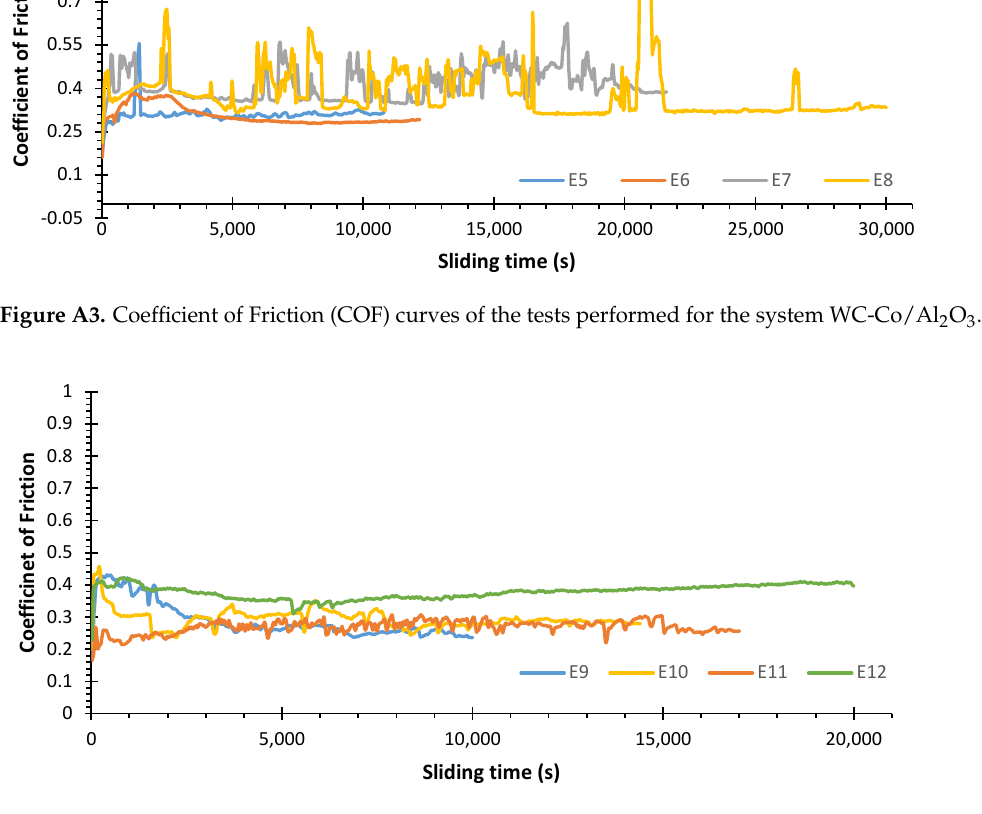
Figure A4. Coefficient of Friction (COF) curves of the tests performed for the system WC-AISI 304/100Cr6.